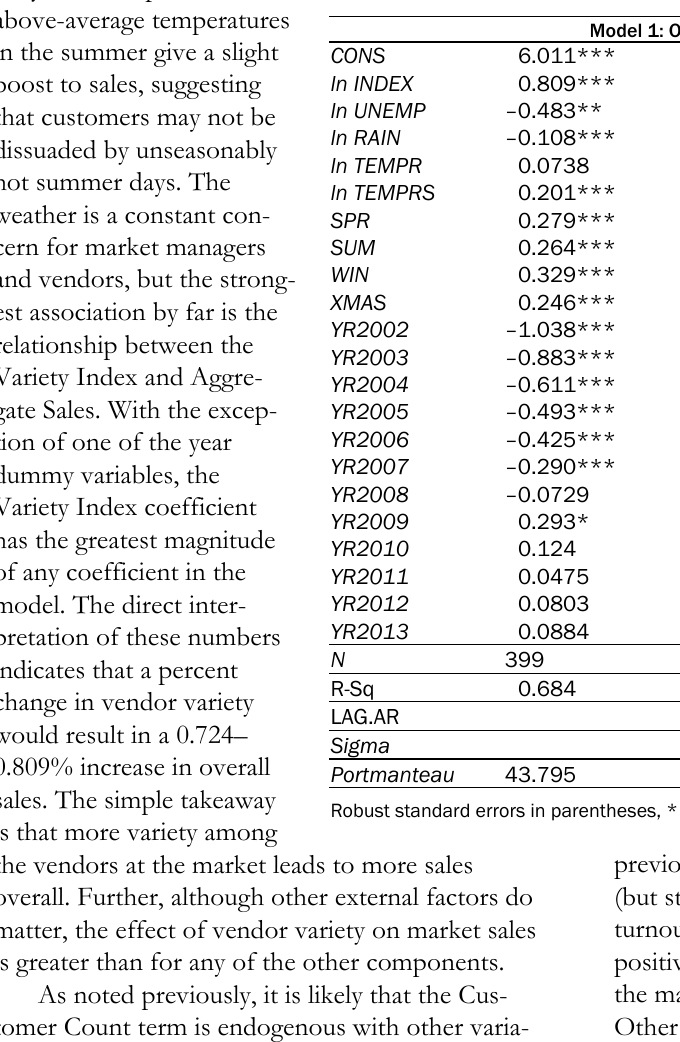
Table 3. Overall Weekly Sales Regression Analysis OLS and ARMAX Model The dependent variable in these models is the natural log( ln) of